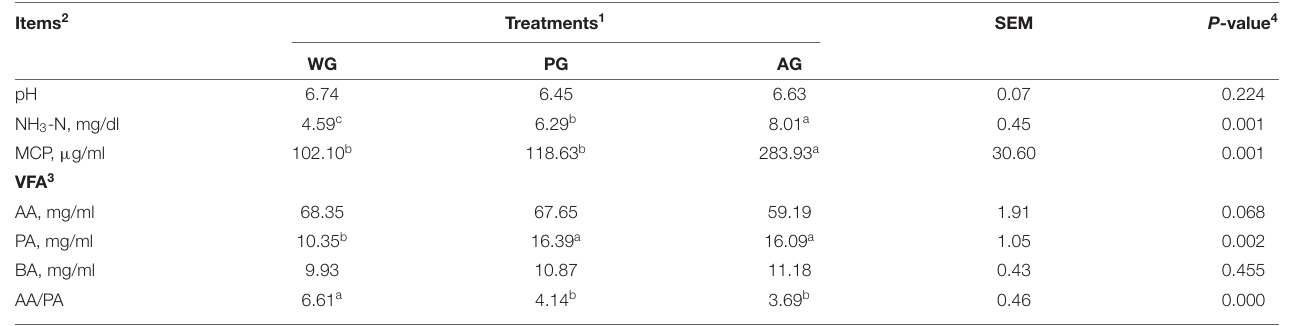
TABLE 5 | Effects of different roughage diets on rumen fermentation parameters in Simmental crossbred steers. Items 2 Treatments 1 SEM P -value